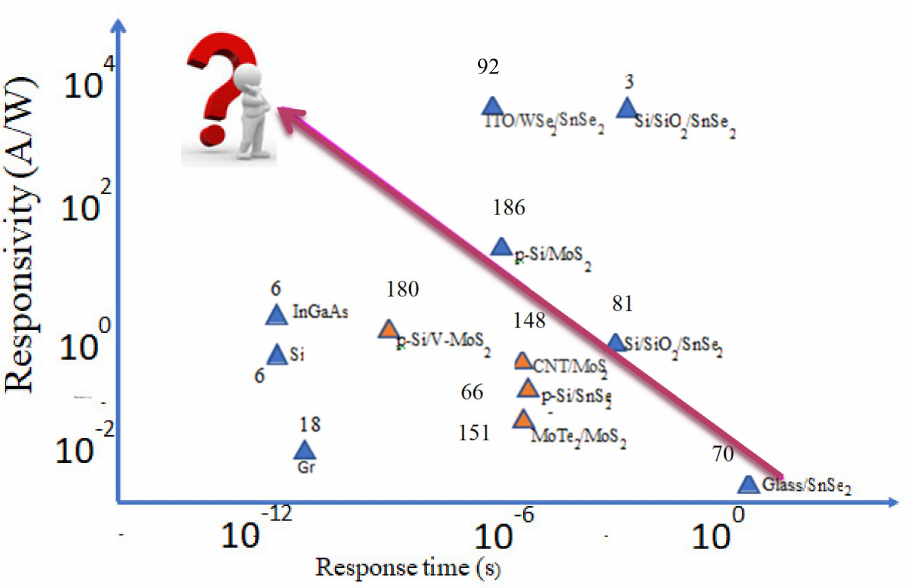
Figure 14. Reported response time and responsivities in comparison to Graphene, Si and InGaAs